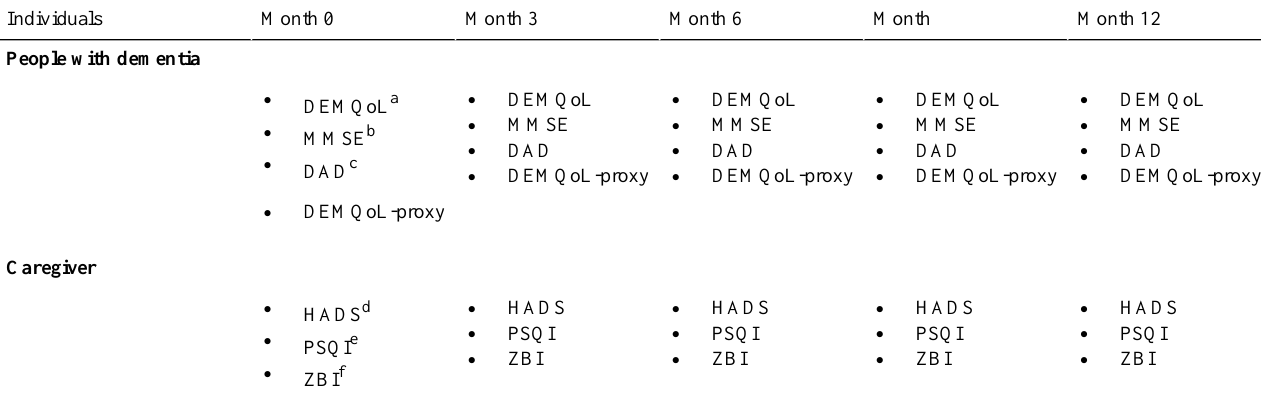
Table 2. Quarterly comprehensive list of well-being evaluation questionnaires and timing with the informal caregiver and people with dementia during the year of